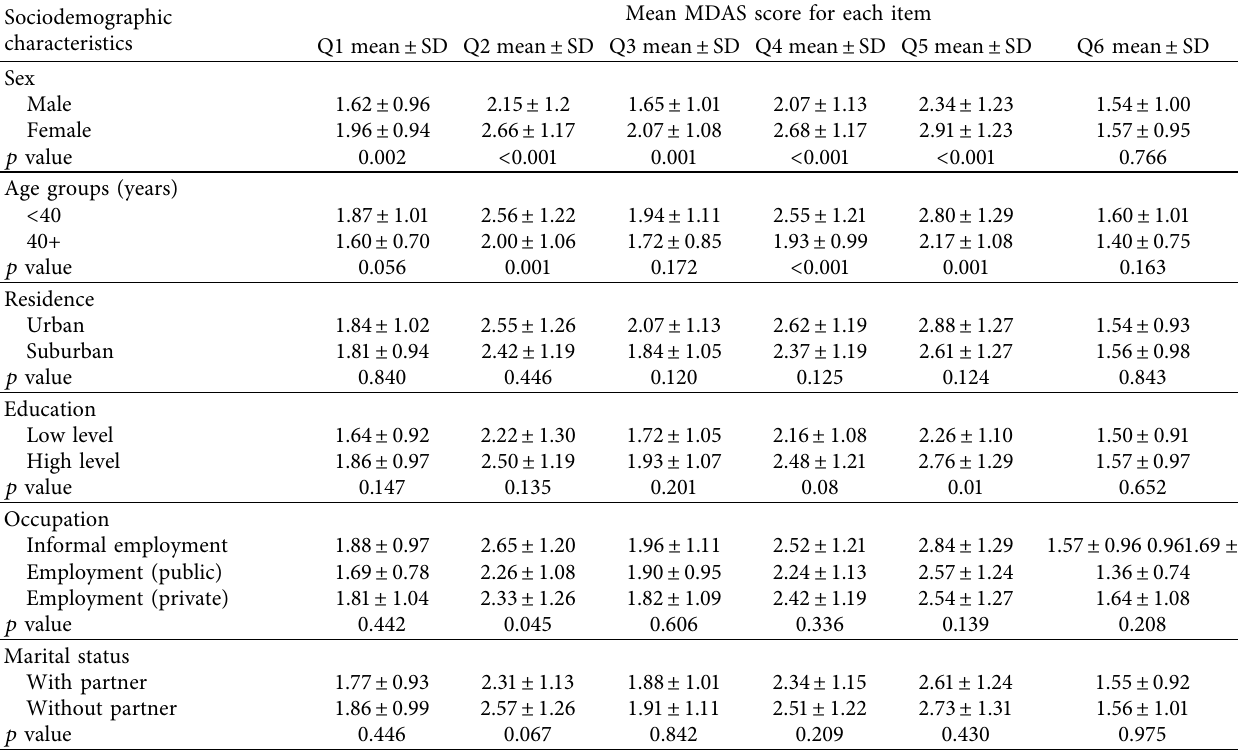
Table 4: MDAS score for each item according to social-demographic characteristics of the participants.